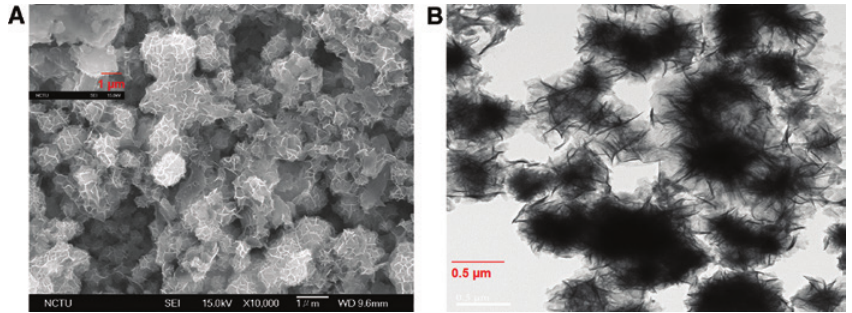
Figure 2: (A) SEM image of CGO, (inset) RG. (B) TEM image of CGO.